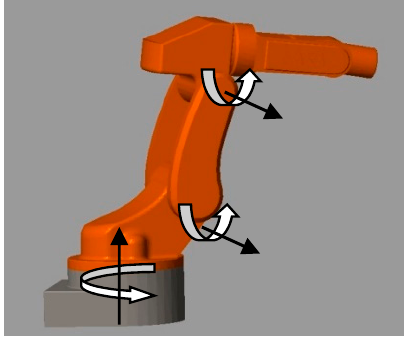
Appl. Sci. 2020 , 10 , x FOR PEER REVIEW Figure 2. A 3-DOF FARA-AT2 robot [47]. Table 1. Parameters of 3-DOF robot manipulator in Matlab simulation. Links Length (m)